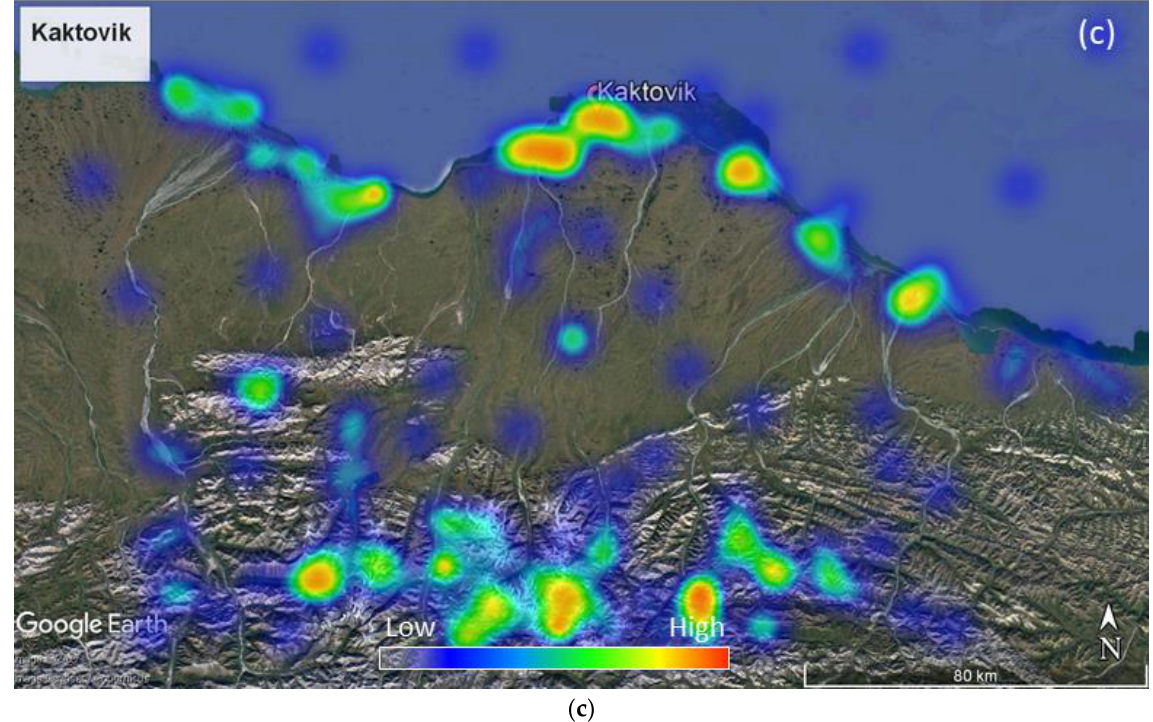
Figure 12. Heatmaps of permafrost degradation and coastal erosion in Kaktovik: ( a ) 800 m, ( b ) 4 km, and ( c ) 80 km.